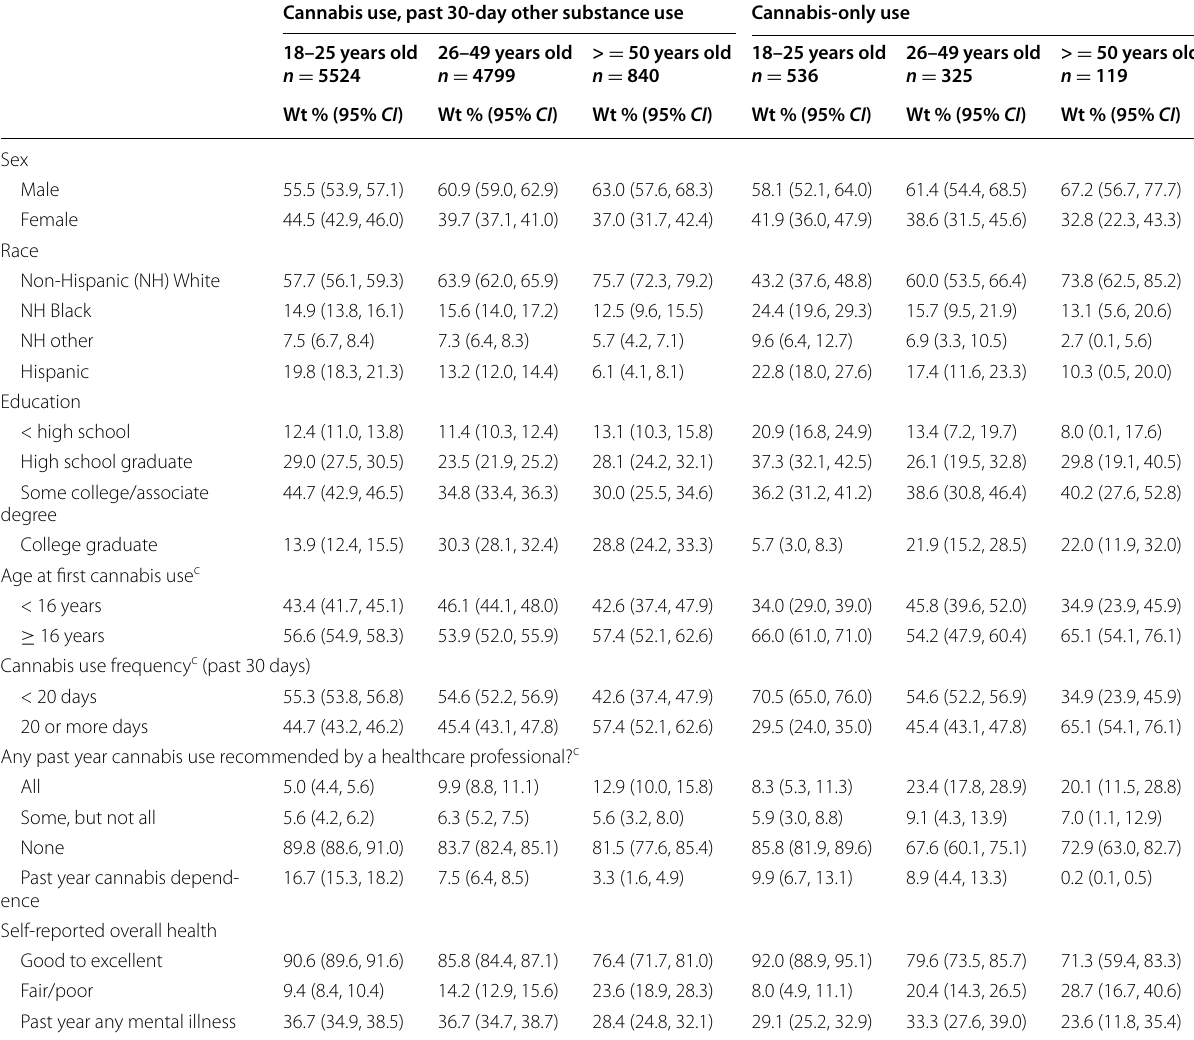
a The National Survey on Drug Use and Health (NSDUH) survey instrument uses the term “marijuana or hashish.” b Other substances included any past 30-day use of the following: any alcohol, tobacco (cigarettes, cigars, pipes, smokeless tobacco); illicit drugs (cocaine, crack, heroin, hallucinogens, LSD, PCP, ecstasy, ketamine, DMT/ AMT/Foxy, Salvia, inhalants, methamphetamine); and pain medications, tranquilizers, stimulants, or sedatives (when use was not directed by a doctor). c Missing < 1% of